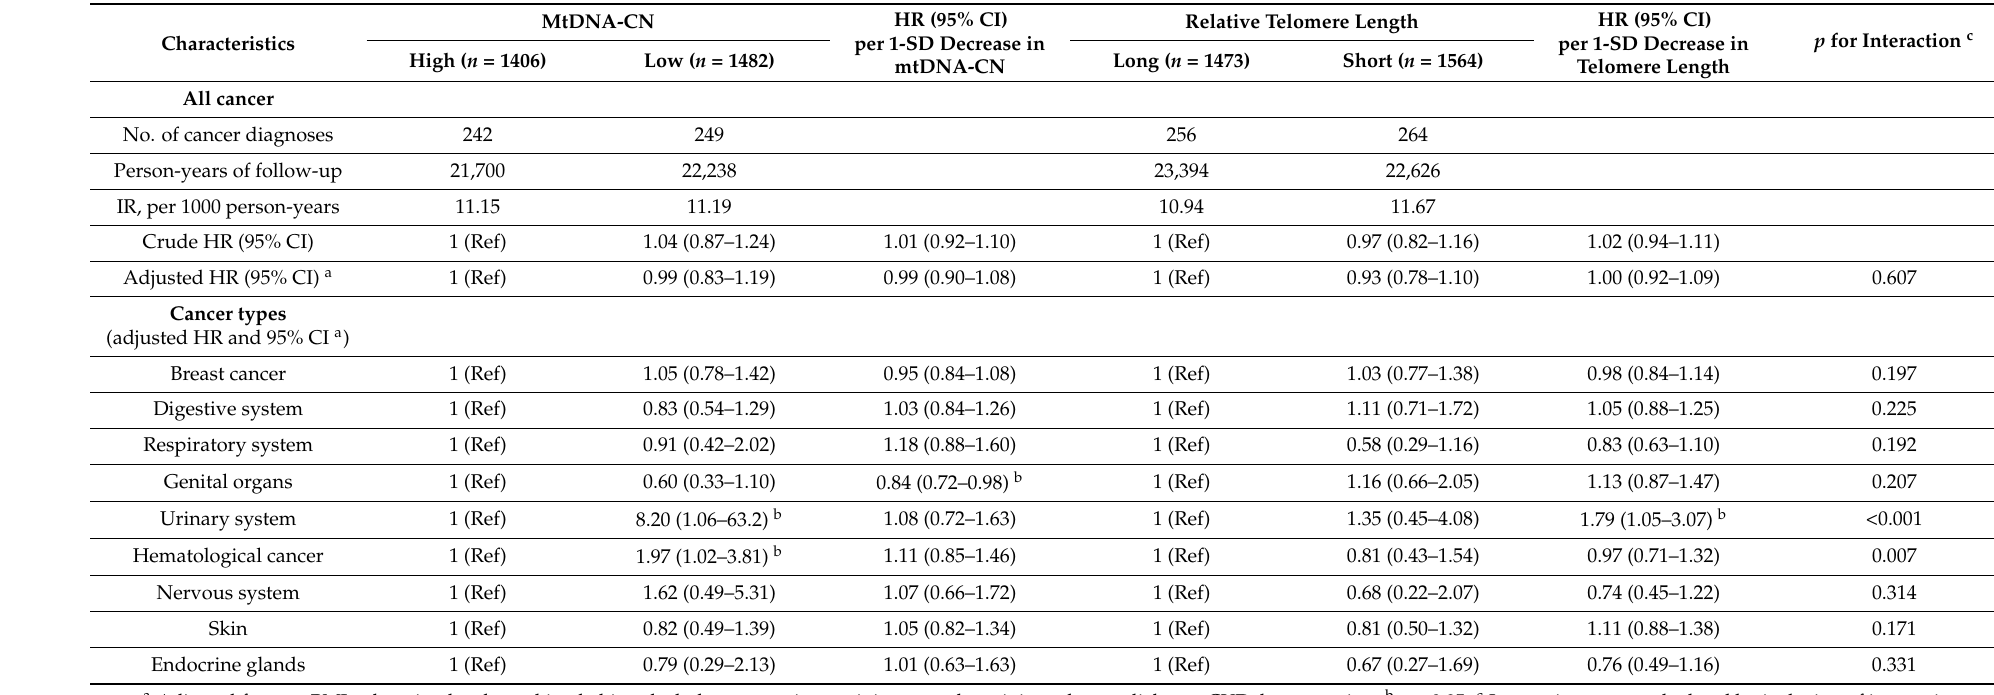
Table 4. Hazard ratios and 95% confidence intervals of cancer incidence associated with mtDNA-CN ( n = 2888) and relative telomere length ( n =